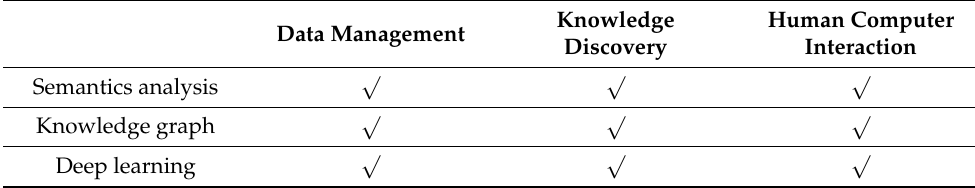
Table 1. Applications of technology in different